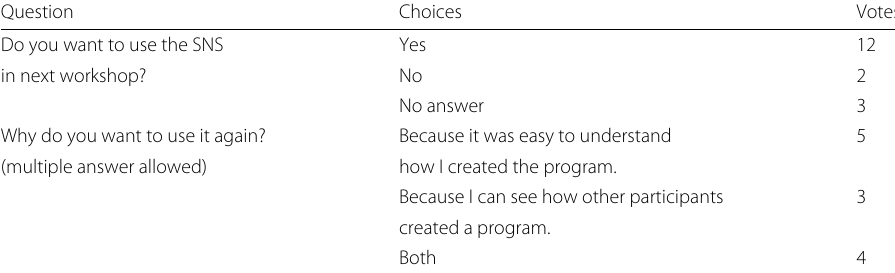
posted several times and most of those posts were made when they came to a break; therefore, reflection occurred many times during one workshop. In addition, as there were accesses to the SNS even after the workshops, those participants had opportunities to review their project once again and had reflection